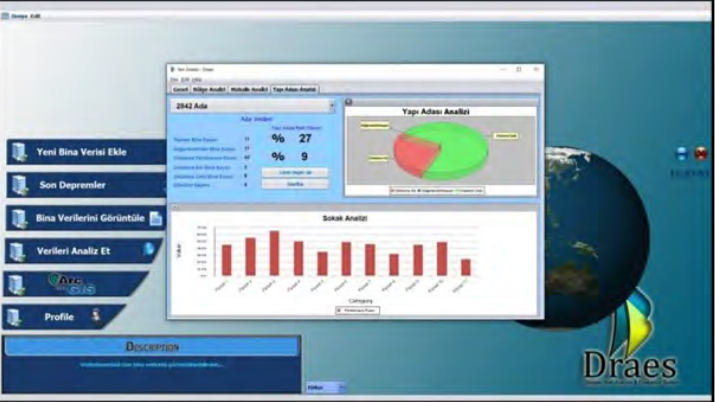
Figure 14. Analysis of Data - Structure Island